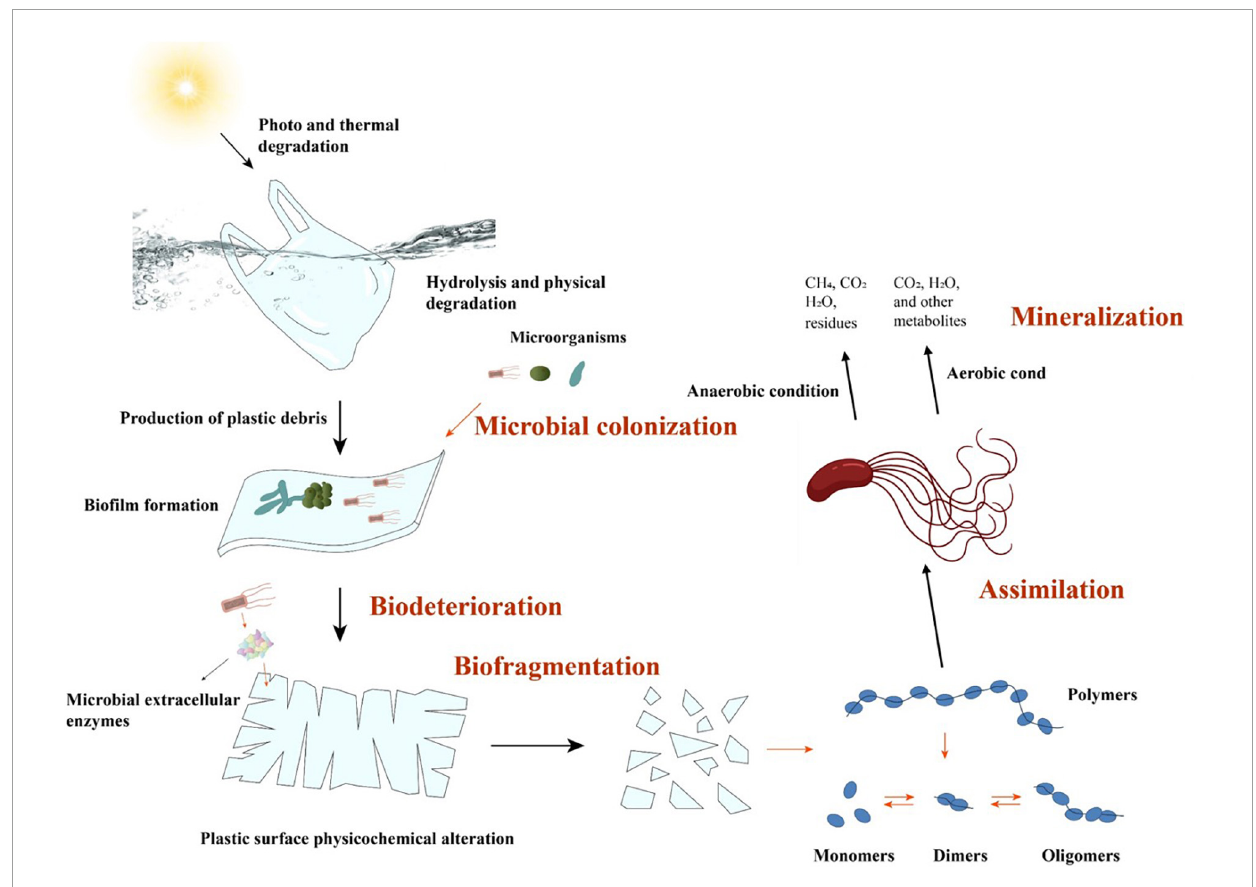
FIGURE2 A diagram of the microbial degradation processes of polyethylene